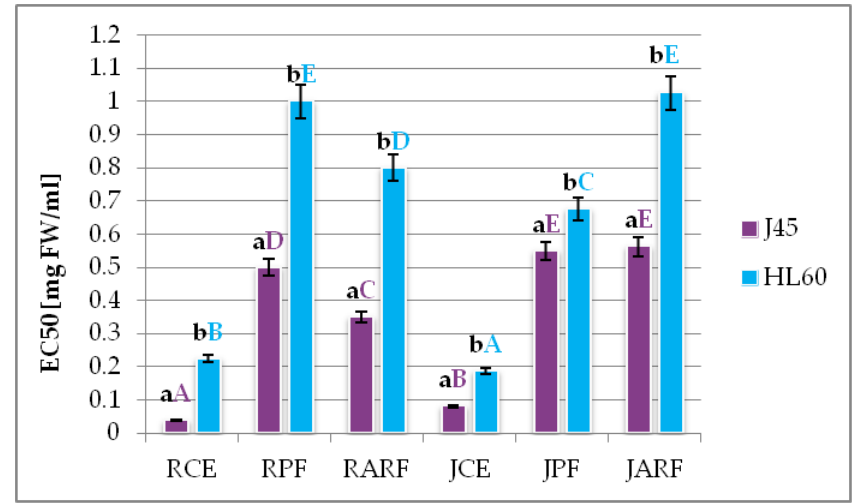
Figure 3. Cytotoxicity of analyzed extracts against J45 and HL60 cell lines [EC50 values]. RCE — raspberry crude extract, RPF — raspberry phenolic fraction, RARF — raspberry anthocyanin-rich fraction, JCE — raspberry juice crude extract, JPF — raspberry juice phenolic fraction,